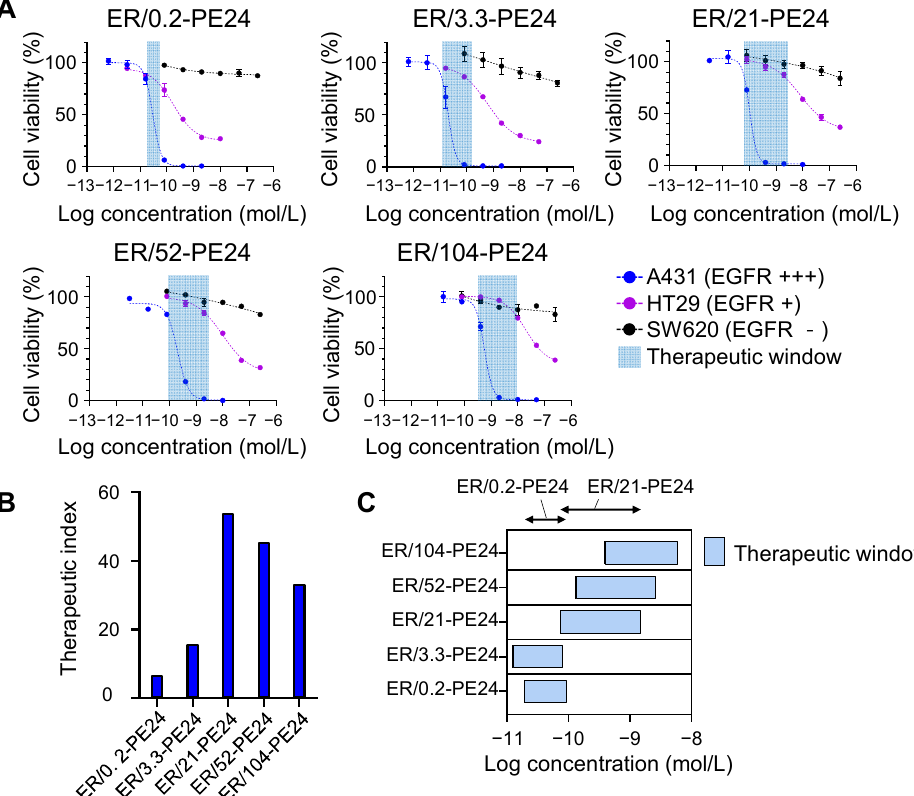
Figure 3. ER-PE24 ITs have different therapeutic windows in vitro depending on the anti-EGFR affinity. ( A ) In vitro cell cytotoxicity assay of ER-PE24 variants in EGFR high-expressing A431 cells, EGFR low-expressing HT29 cells, and EGFR negative SW620 cells. Each cell line was cultured with the indicated ER-PE24 ITs at various concentrations for 72 h, before the determination of cell viability using the CellTiter-Glo assay. Error bars represent the mean ± SD ( n = 3). ( B ) The therapeutic index of each ER-PE24 was calculated by dividing [IC 50 against HT29 cells] by [IC 50 against A431 cells]. ( C ) The therapeutic window of each ER-PE24 was estimated by the range between the IC 20 values against A431 and HT29, i.e., [IC 20 against A431 cells]–[IC 20 against HT29 cells]. The values of the therapeutic index and therapeutic window of each ER-PE24 variant are listed in Table 2. Table 2. The IC 50 , therapeutic index, and therapeutic window of ER-PE24 ITs in vitro. (a)